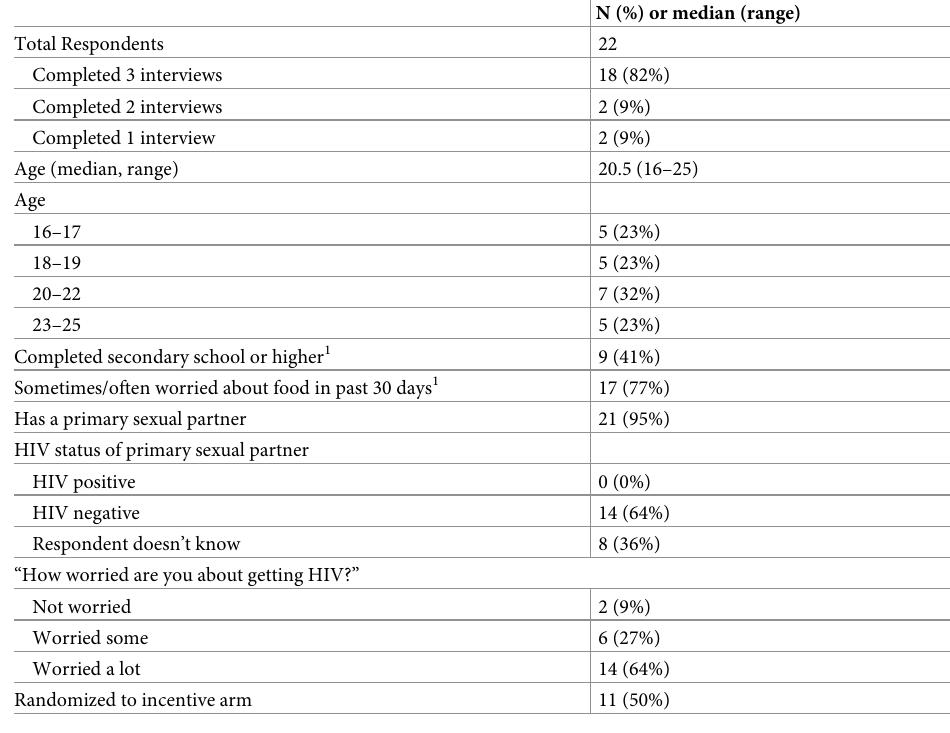
Table 1. Baseline qualitative sample characteristics.